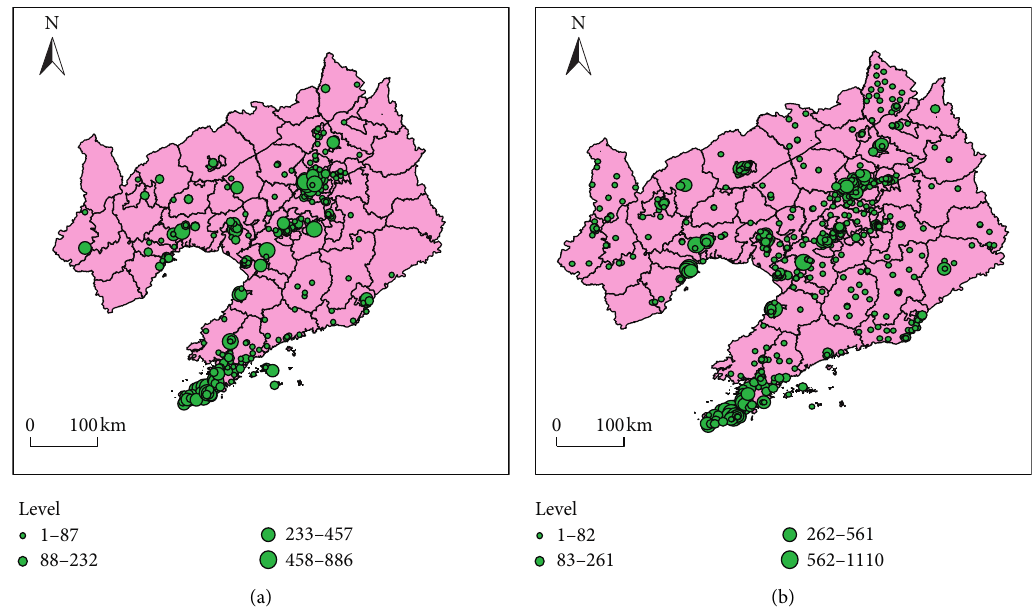
Figure 4: Spatial variation of the scale of secondary schools in Liaoning Province (a) in 2008 and (b) in 2017.